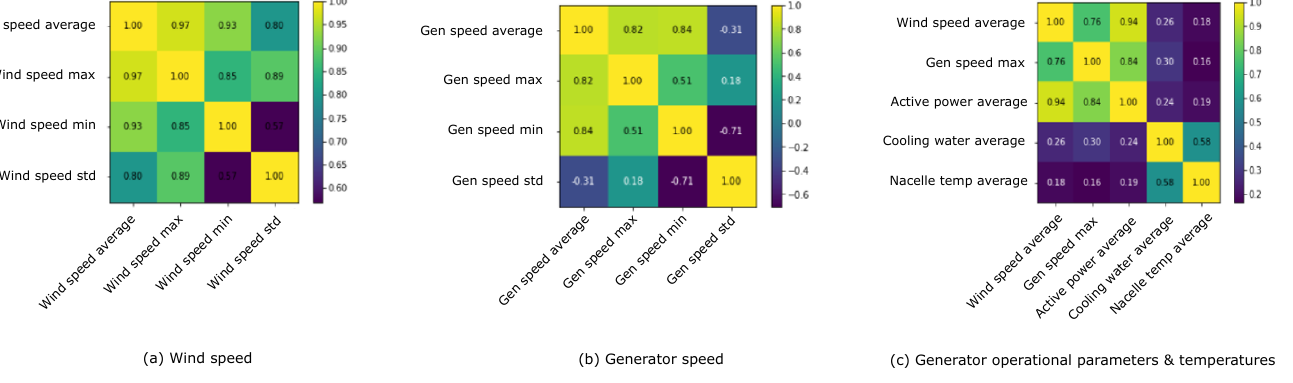
Figure 4. Pearson coefficient for assessing linear correlation.